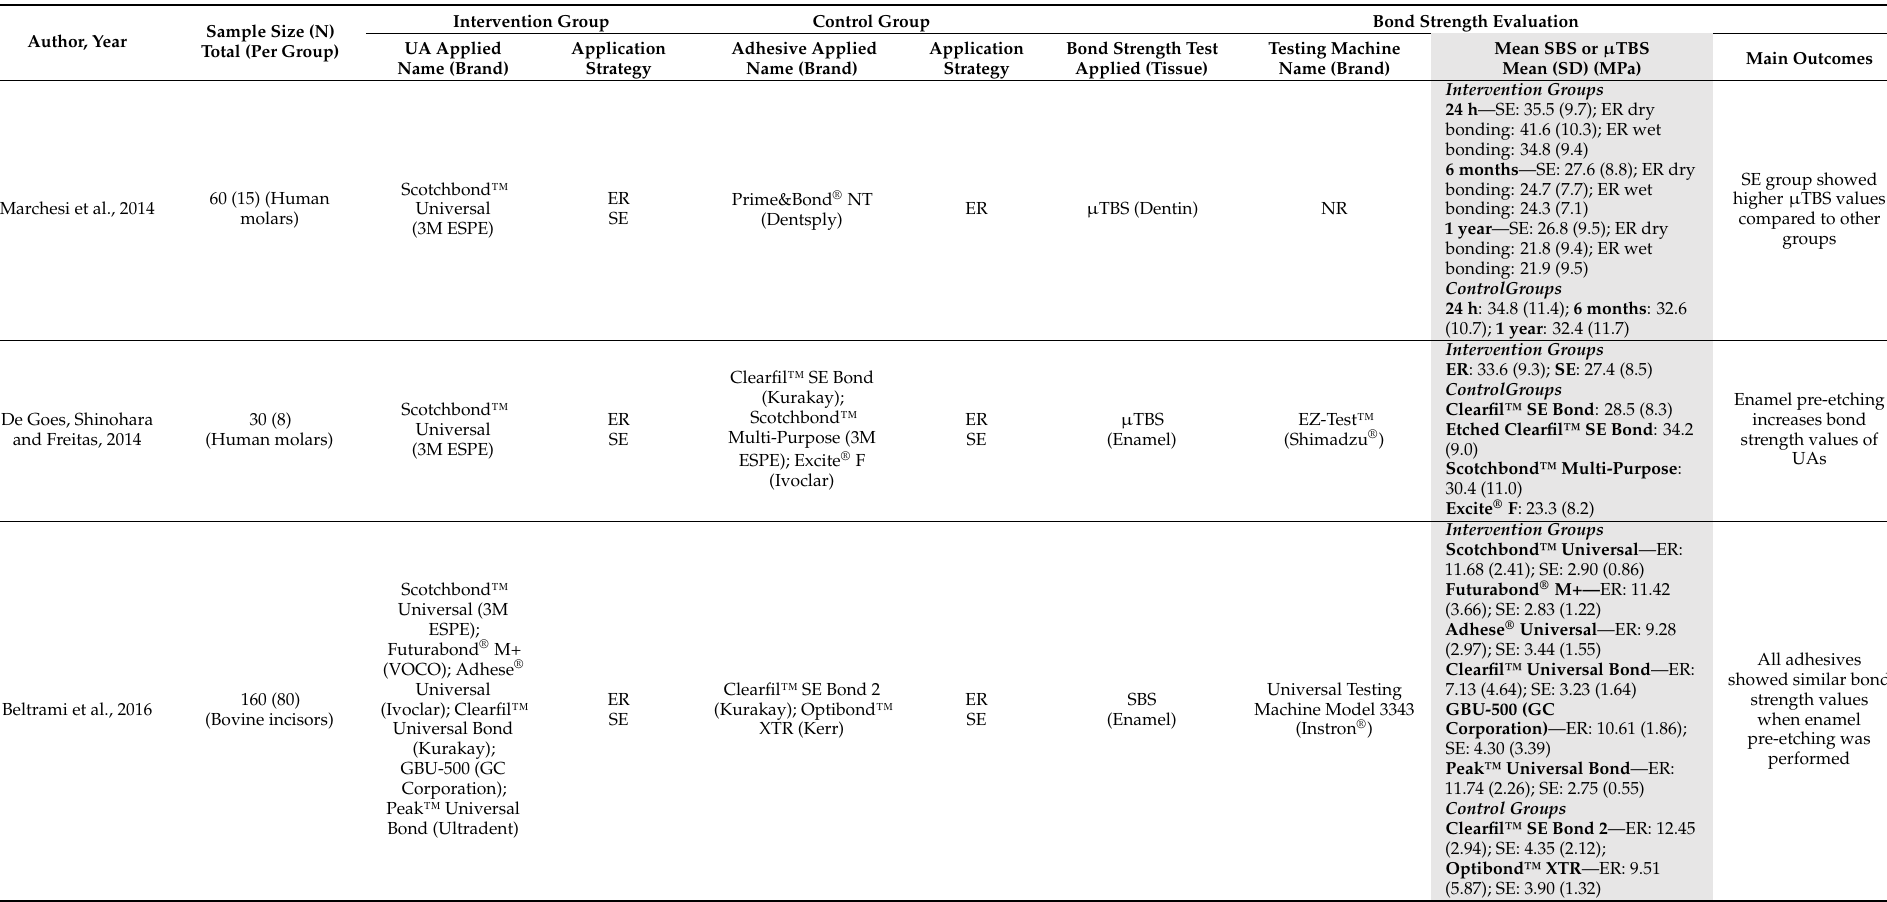
Table 2. Summary of the reviewed in vitro studies